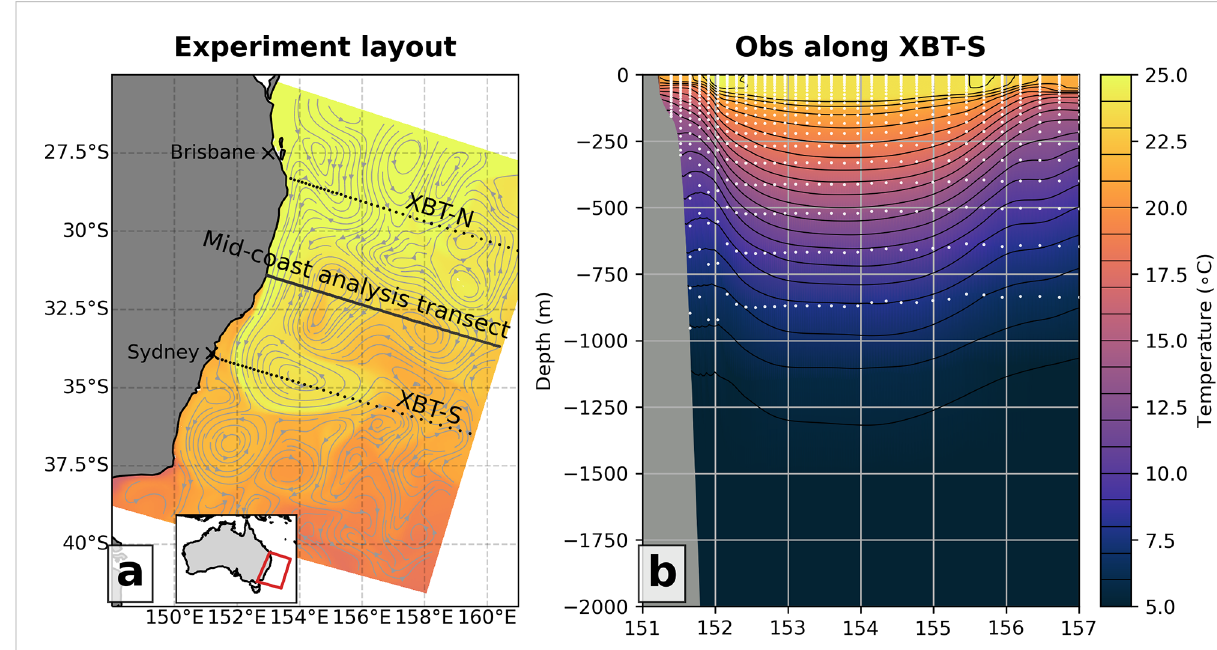
FIGURE 1 (A) A snapshot of model SST at 11-March 2012 is shown for the East coast of Australia. Dots mark deployment locations of XBTs along the XBT- N (beginning at ~28.5°S) and XBT-S (beginning at ~34°S) transects and the line shows the analysis transect beginning at ~31°S. Major east coast cites Brisbane and Sydney are marked, and grey vectors show model surface currents at the same time. (B) Temperature measurement locations are marked as grey dots in this vertical slice of temperature (at the same time as in panel A ) along the XBT-S deployment line (see A ). Inset in (A) shows model